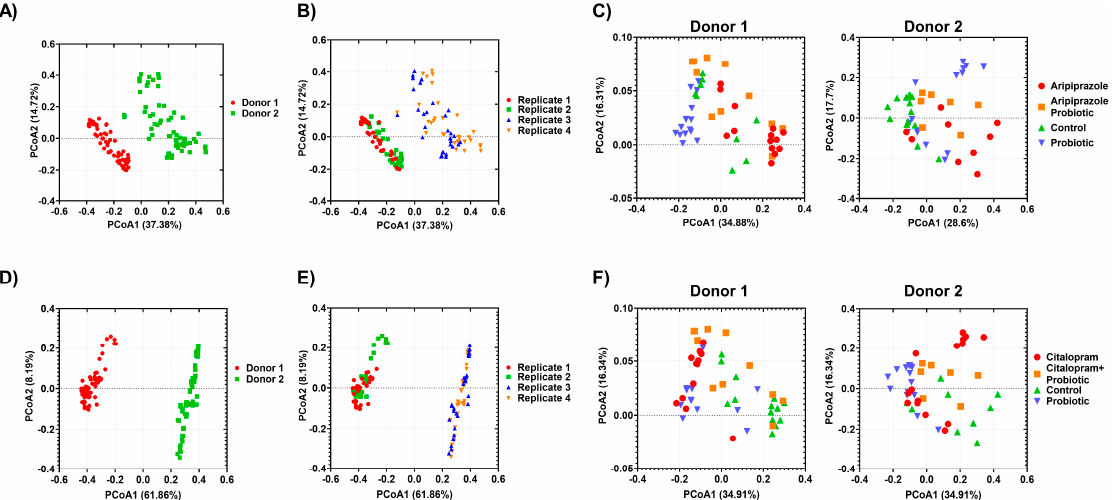
Figure 3. Plots of Principal Coordinate Analysis (PCoA) based on Bray-Curtis distances among the identified microbiota in different samples. ( A – C ): effect of aripiprazole treatment; ( D – F ) effect of (S)-citalopram treatment. The PCoA figures show clustering based on source donor ( A , D ); experiment replicate ( B , E ) and treatments of each donor microbiota ( C , F ). The samples were colored as indicated in legends. PCoA1 and PCoA2 represent the top two coordinates that captured the highest microbial variability among samples, and the percentage shown indicates the fraction of variation represented by each